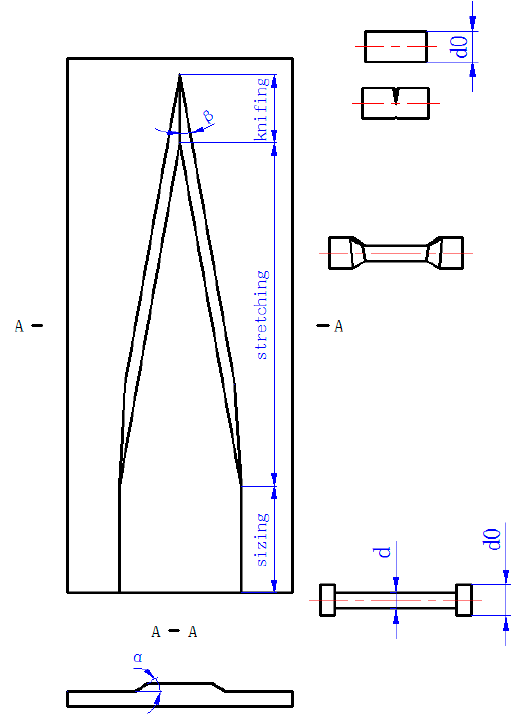
Figure 1. CWR (cross wedge rolling) process.